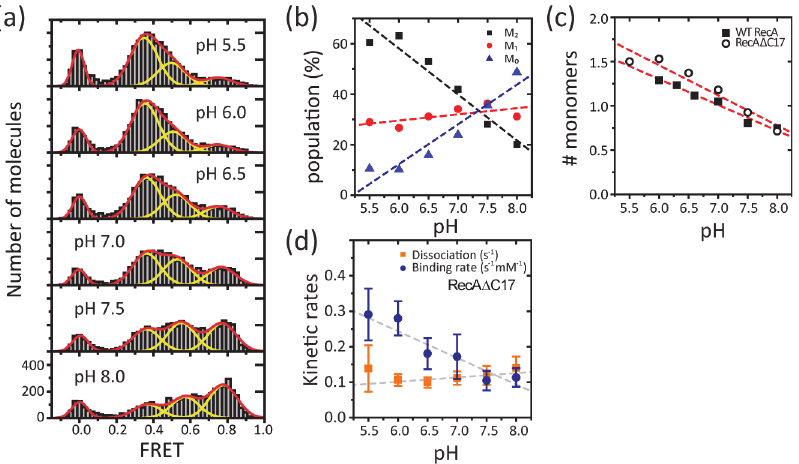
Figure 3. pH Dependence of the RecA Δ C17 Filament at the 5 0 -disassembly End. (a) Single molecule FRET histograms obtained at various pH with a RecA mutant of which negatively charged 17 amino acids in CTD are truncated (RecA Δ C17). 0.5 μ M RecA Δ C17 and 1 mM ATP were added in the reaction buffer with the same buffer condition as in Fig. 1. The histogram was fit with three Gaussian peaks for M 0 , M 1 , and M 2 state, respectively, with additional peak at 0 for donor-only molecules. (b) The population for each peaks (symbols) found in (a) at various pH. Dashed lines are eye guides. (c) Average number of monomers bound between donor and acceptors (open circles for RecA Δ C17) calculated from (b): N average = 2 * P(M 2 ) + 1 * P(M 1 ) +0 * P(M 0 ), where P(M i ) is the population in M i state. Red dashed line is a linear fit to the data with a slope − 0.34 for RecA Δ C17. Data obtained with wild type RecA in Fig. 1D is also shown for comparison (filled rectangles). (d) The binding (blue) and dissociation (orange) rates of RecA Δ C17 at different pHs. The error bars are standard deviations from three independent measurements. The slopes obtained by linear fit (dashed lines) are 0.01 and − 0.07 for the dissociation and the binding rates, respectively.